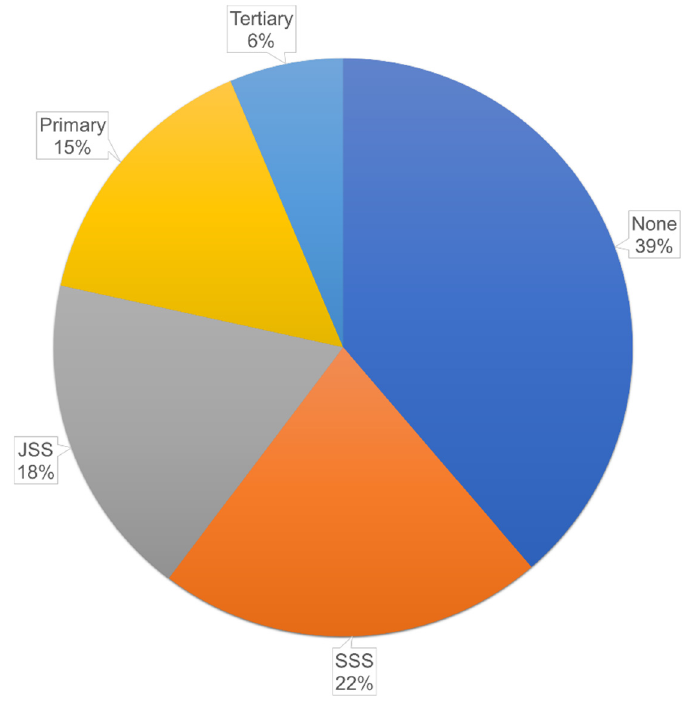
Figure 10. Formal education and training completed by respondents as assets for flood adaptation. Source: Fieldwork.